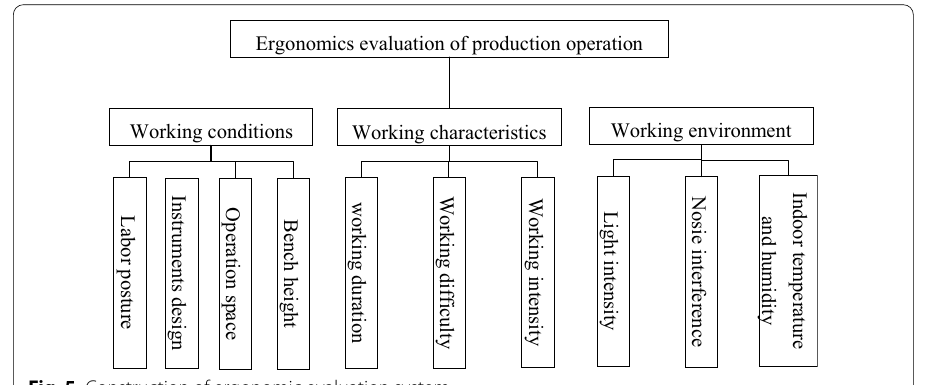
Fig. 5 Construction of ergonomic evaluation